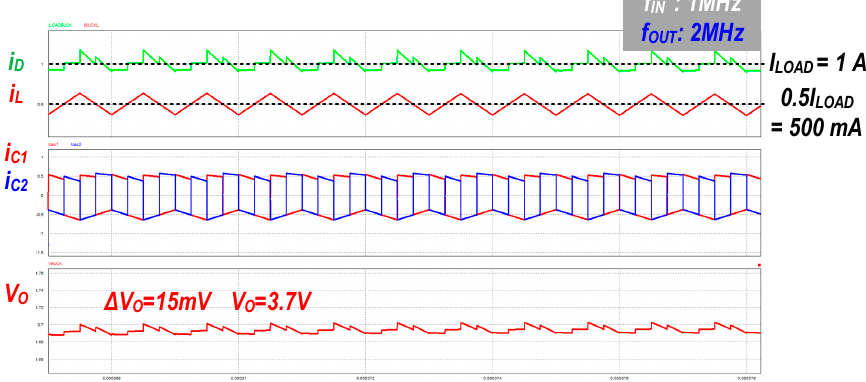
= 1 MHz and f = 2 OUT